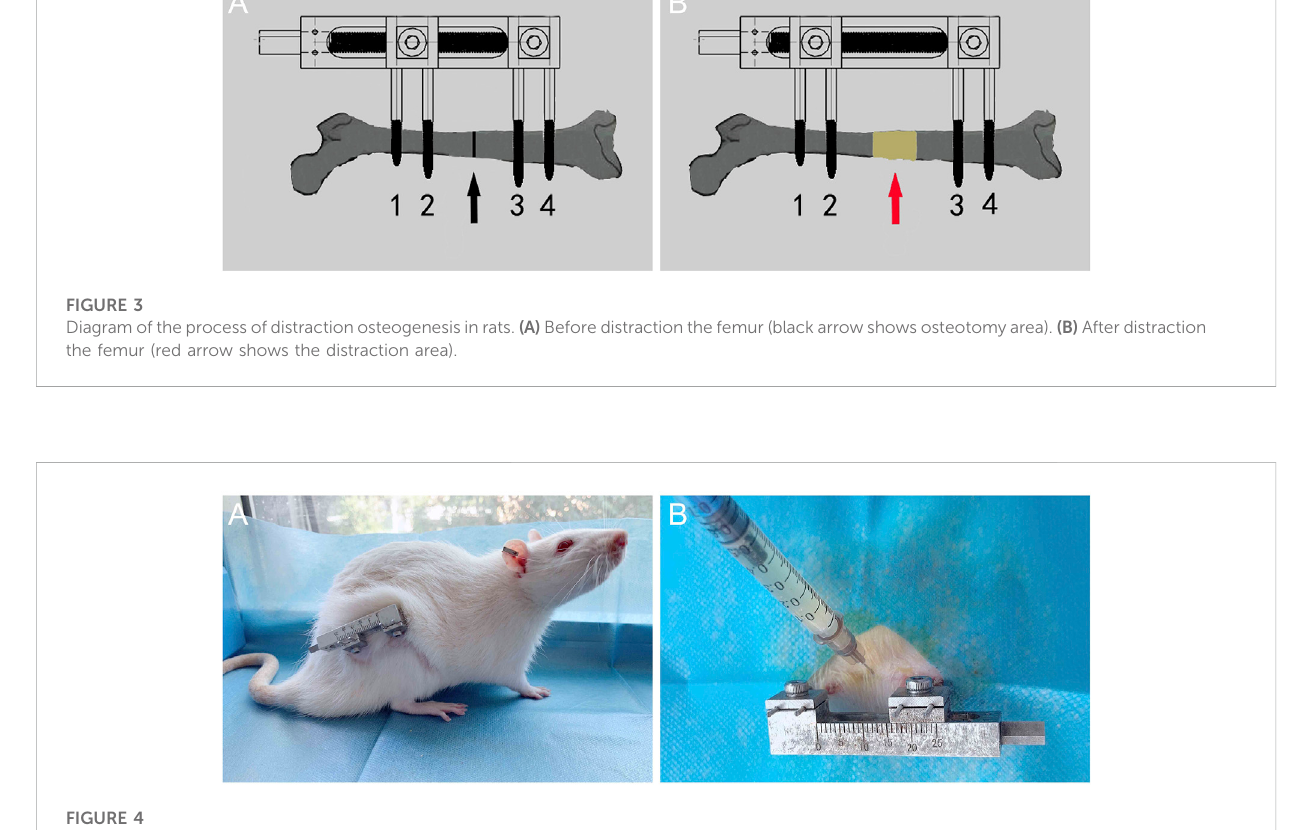
Frontiers in Bioengineering and